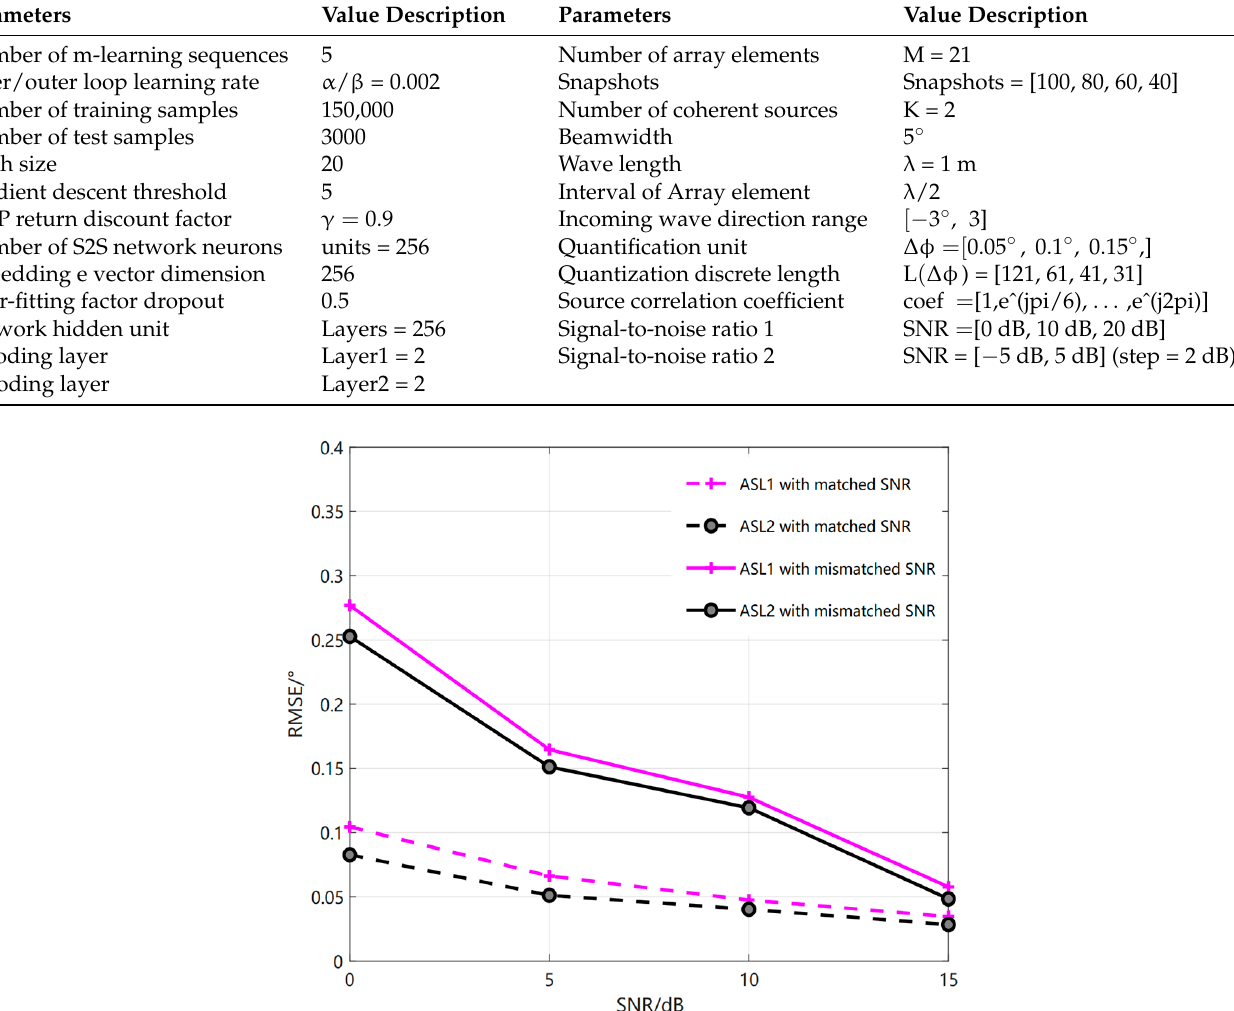
Figure 3. Relationship curve between RMSE and Snapshots (The real line is mismatched, and the imaginary line is matched.). 4.1. Loss Function Trained under Different Influences The simulation parameters are set as incoming wave angle range [ − 3 °, 3 ° ], SNR = 5 dB, and Snapshots = 40 to conduct the experiments under different quantization influ- ences. Firstly, the meta − knowledge experience is obtained from the meta − training phase under the first training parameter, and secondly, based on the meta − knowledge experi- ence obtained from the meta − training phase, effective generalization training is per- formed in the meta − testing phase using a small number of samples to complete the exper- iments under different influences as follows. Since the quantization unit Δϕ directly affects the length of the sequences, the ex- periments are conducted with different training parameters Δϕ = [0.05 ° , 0.1 ° , 0.15 ° , 0.2 ° ] for the quantization units, respectively, and the input sequence length L = 121 and the output sequence length L-1 = 120 when Δϕ is 0.05. The experimental results are shown in Figure 4. The S2S network model based on the knowledge experience obtained under the first training parameter in the meta − training phase still maintains stable performance for different sequence lengths in the meta − testing phase, and basically starts to converge after 20 iterations. Since the MDP model takes into account the influence between similar tasks